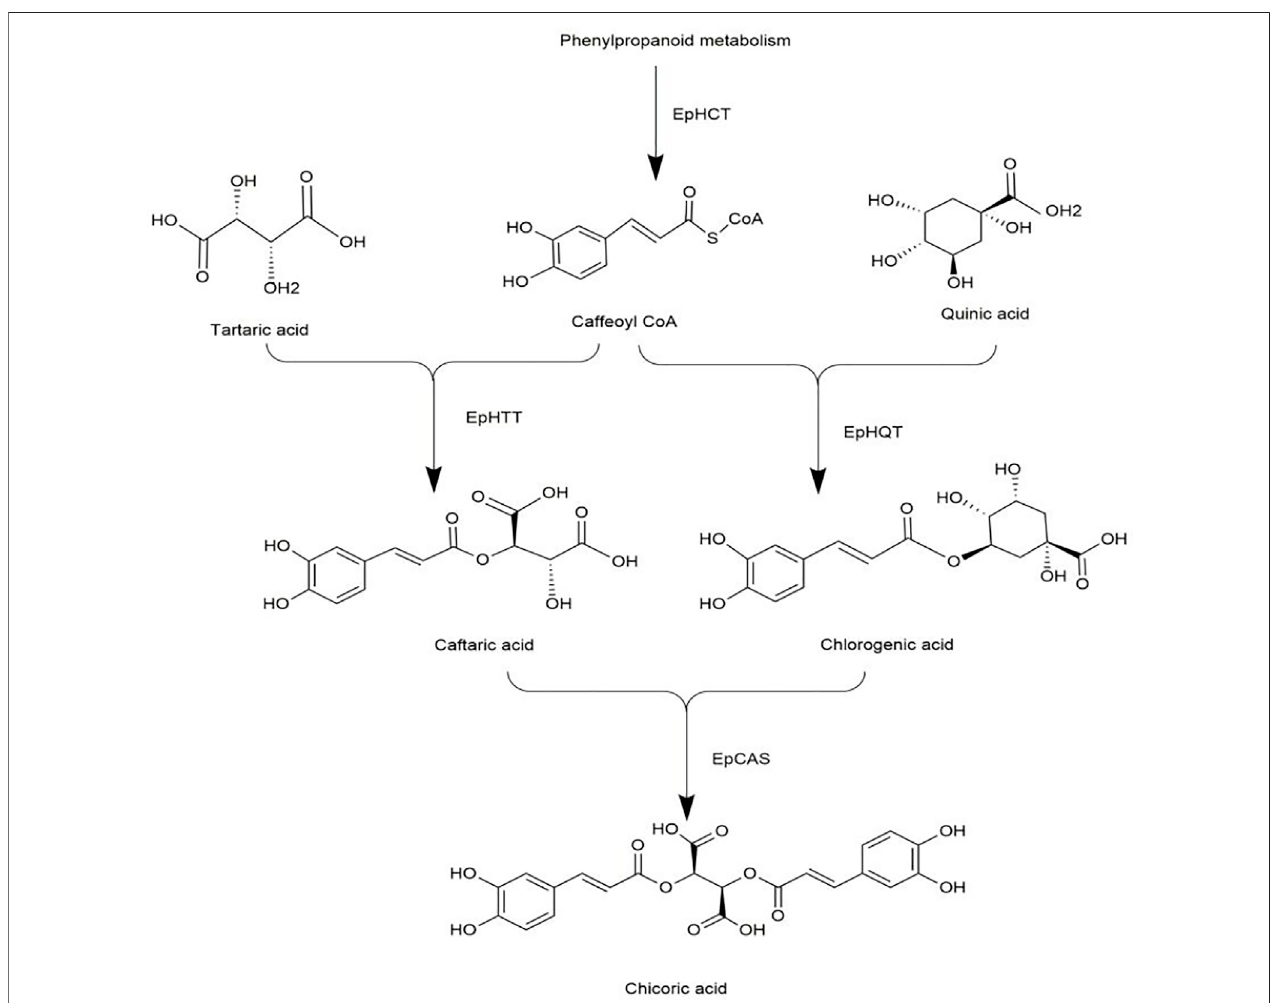
FIGURE 9 | Biosynthetic pathway of chicoric